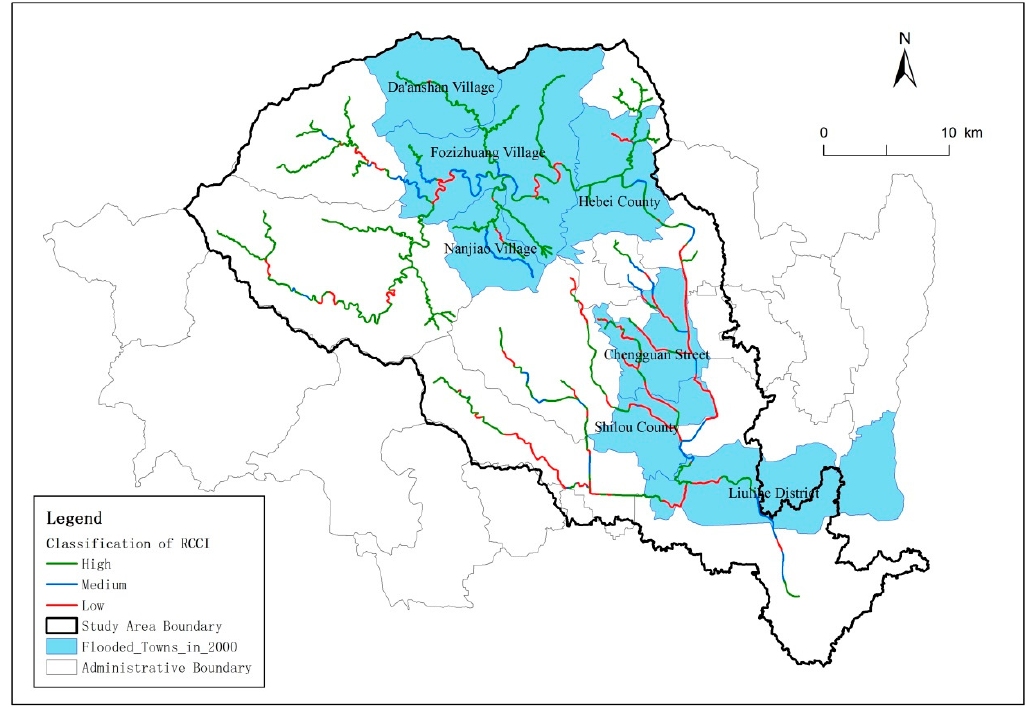
Figure 7. RCCI model validation by the flooded town data of 4 July 2000.